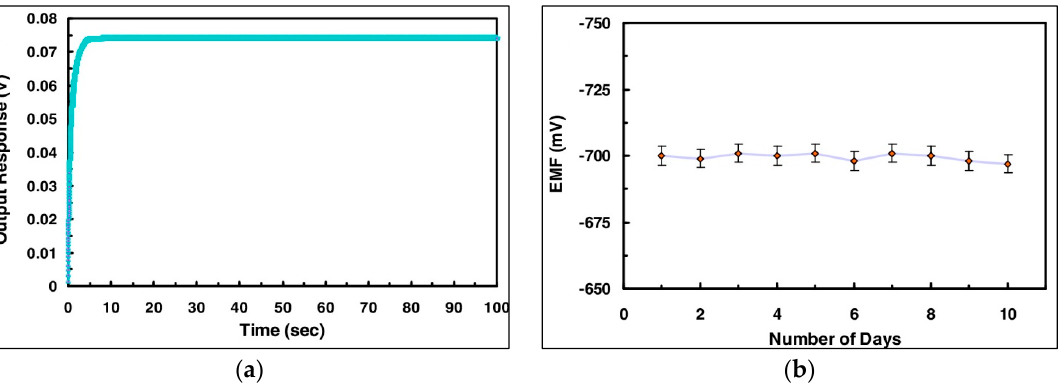
Figure 3. ( a ) SEM image of three-dimensional ZnO dahlia-flowers. ( b ) Repeated calibration curves for the cholesterol biosensor against a standard Ag/AgCl reference electrode [24].